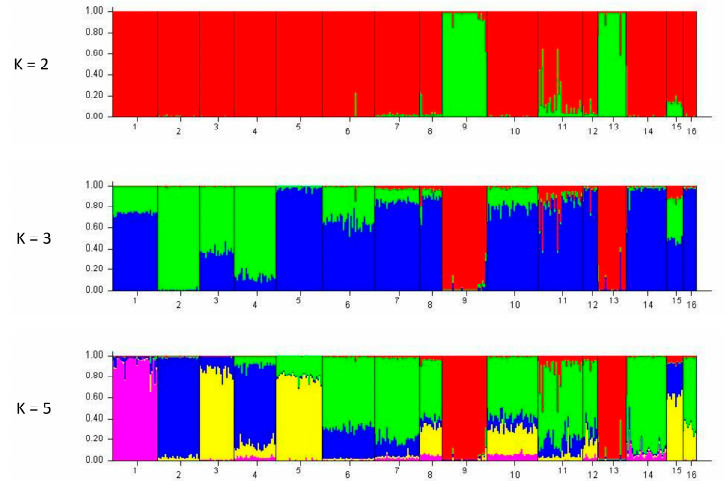
Figure 3. Graphical display of the results of the STRUCTURE analysis, inferred at K = 2, K = 3, and K = 5. Each population accession is represented by a vertical line segmented into a number of colors identical to the K number: 1—Finisterra (“FIN”); 2—Viana do Castelo (“VCA”); 3—Aveiro (“AVE”); 4—Rio Maior (“RIO”); 5—Vaiamonte (“VMT”); 6—Oeiras (“OEI”); 7—Comporta (“CMP”); 8—Tavira (“TAV”, B. vulgaris subsp. maritima ); 9—Tavira (“TAVX”, B. macrocarpa ); 10—Fuseta (“FUS”); 11—Ludo (“ML”,); 12—Quinta de Marim (“PM”, B. vulgaris subsp. maritima ); 13—Quinta de Marim (“PMX”, B. macrocarpa ); 14—Almeria (“ALM”); 15—Azores (“AZO”); 16—Madeira (“MAD”). At K = 2, B. vulgaris subsp. maritima is represented by (red color ) and B. macrocarpa by green color ; at K = 3 and K = 5, B. macrocarpa is represented by red color. The two groups assigned at K = 2 correspond to B. vulgaris subsp. maritima popula- tions (red color) and B. macrocarpa (green color). B. vulgaris subsp. maritima and B. mac-